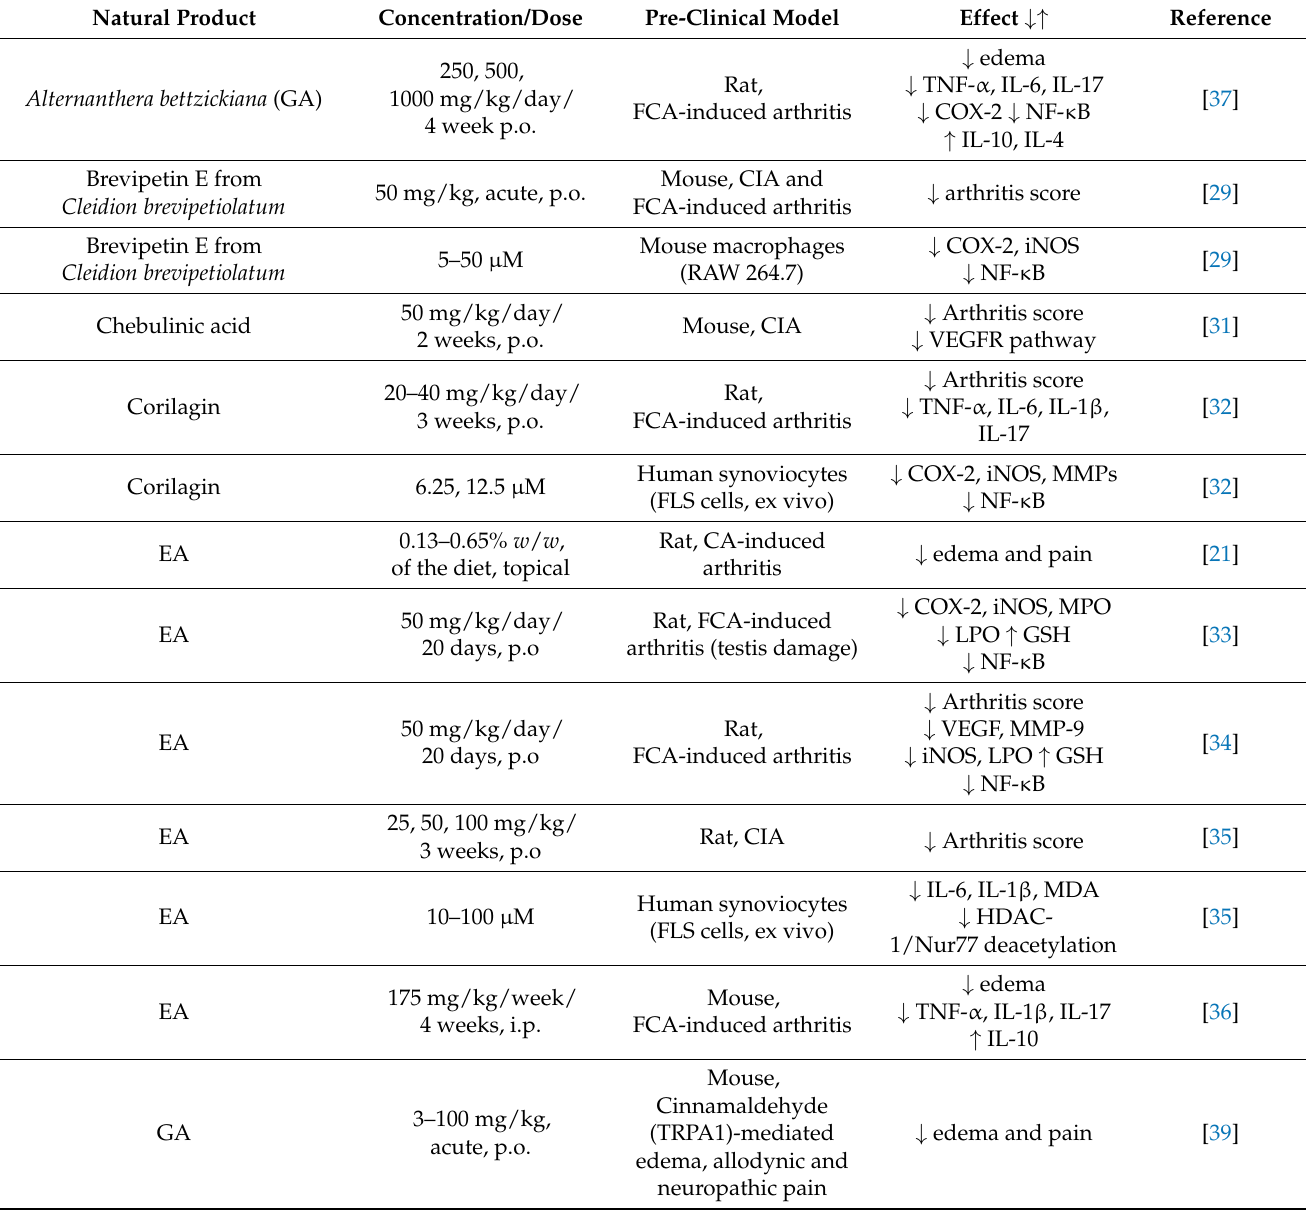
Table 1. Collection of recent articles concerning the biological activity of HTs and their metabolites in RA